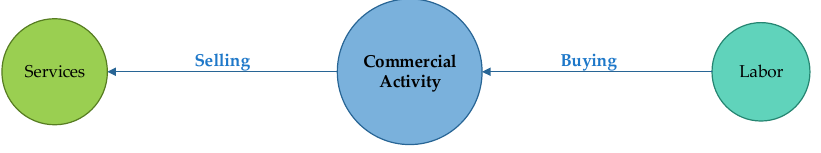
Figure 14. Buying and selling process of commercial activities.